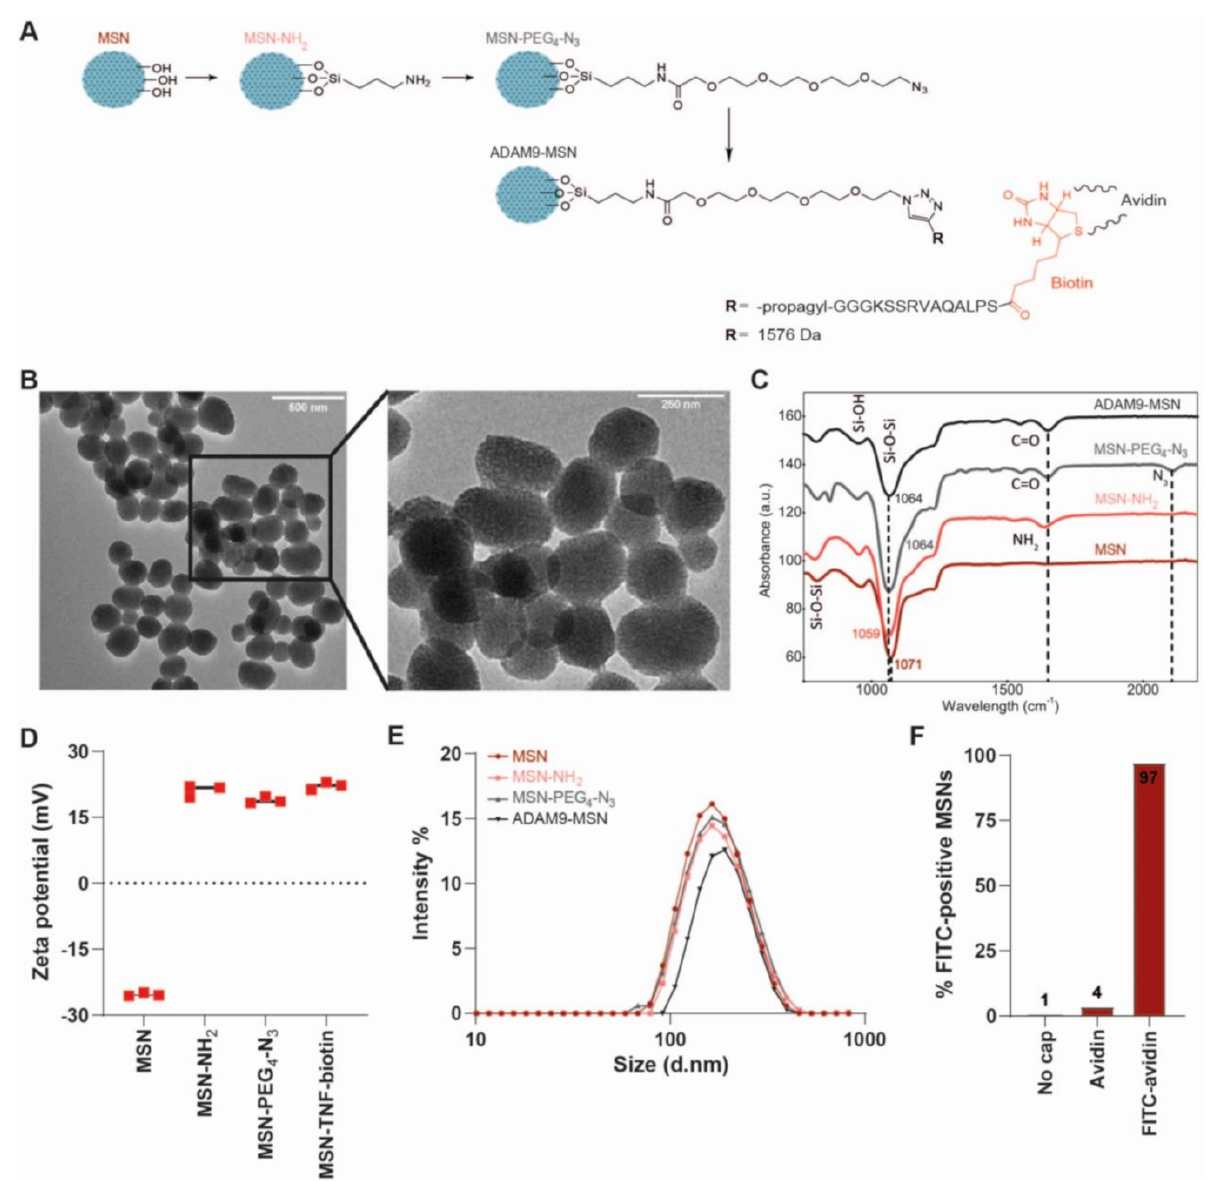
Figure 3. Synthesis and characterization of ADAM9-MSNs. ( A ) Schematic overview of the stepwise synthesis of peptide– biotin coupled MSNs. ( B ) Transmission electron microscopy images of peptide–biotin coupled MSNs. ( C ) Fourier-transform infrared spectra, ( D ) zeta potential, and ( E ) hydrodynamic diameter of the (un)conjugated MSNs. ( F ) Flow cytometry data of FITC-avidin-capped